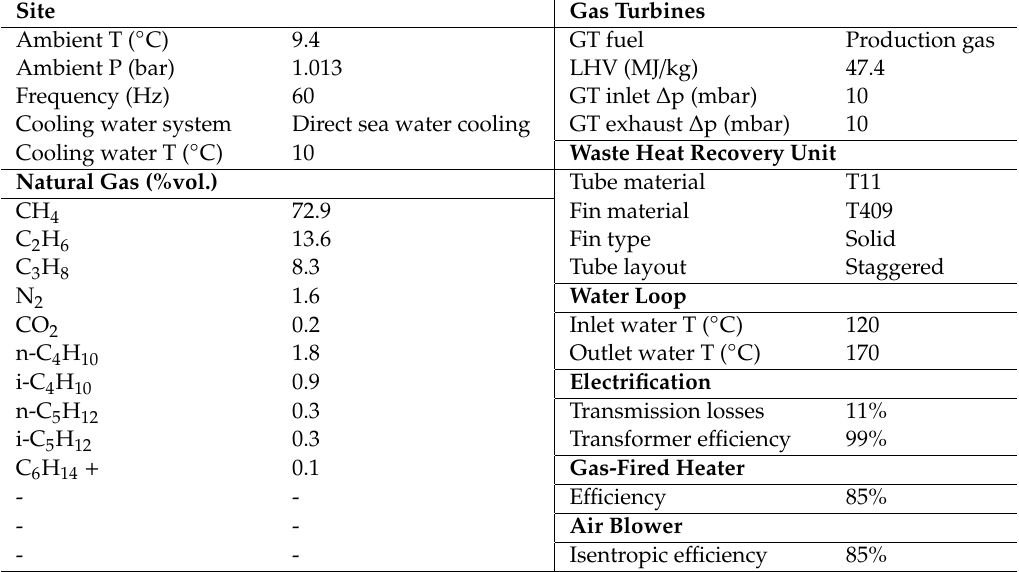
Table 1 sums up the main assumptions used in the modeling. Table 1. Site conditions used and main modelling